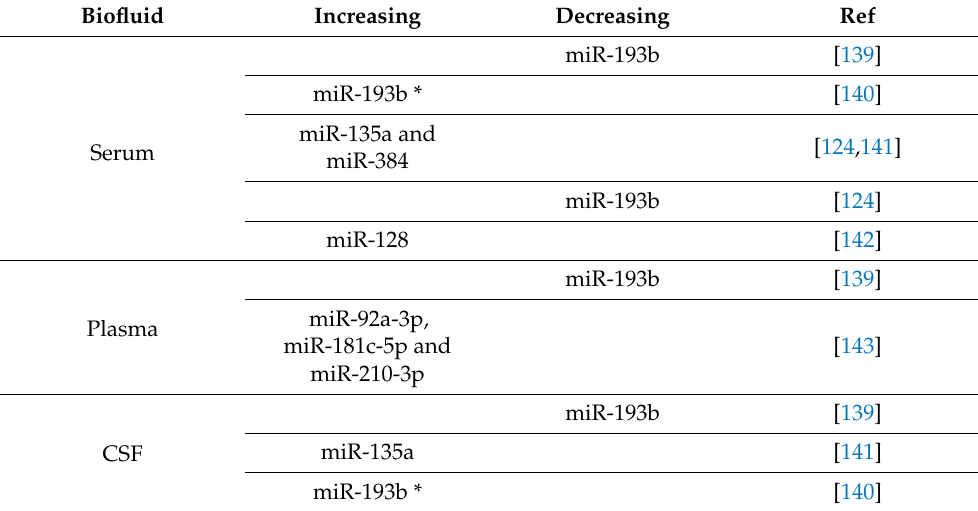
Table 3. Examples of exosomal miRNA biomarkers in AD.